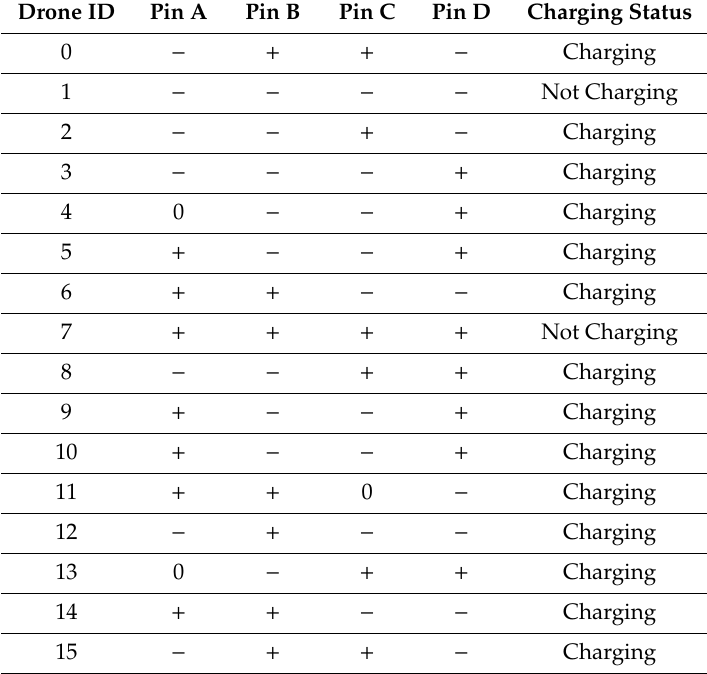
Table1. Thecases ofchargingconditions, where thefourcontact pointsand thetwosignals (positive and negative) are embedded in the truth table to review charging condition probabilities.